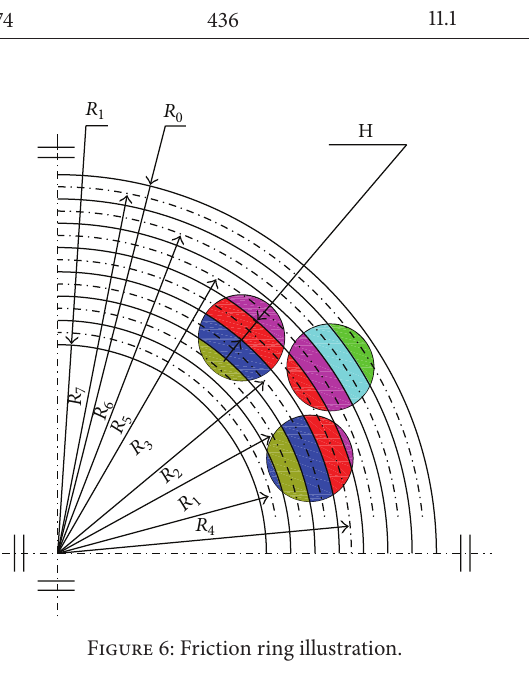
Figure 6: Friction ring illustration.